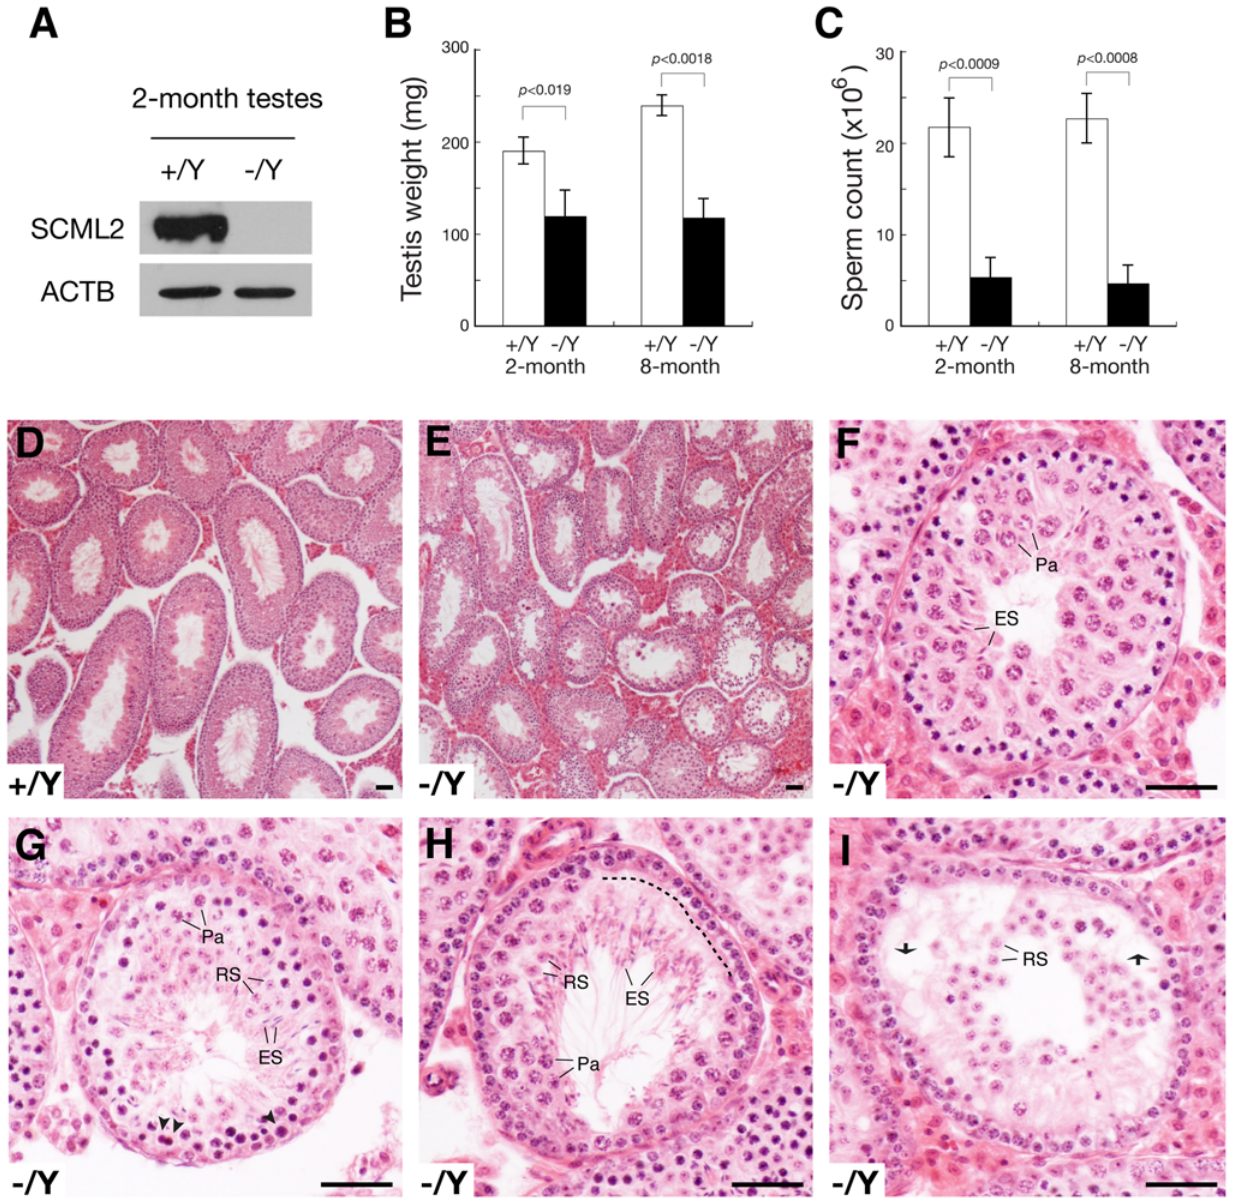
Figure 2. Defective spermatogenesis in Scml2 -/Y mice. (A) Western blot analysis of wild type and Scml2 -/Y testes. (B) Dramatic testis weight reduction (per pair of testes) in Scml2 -/Y mice. (C) Sharp reduction in sperm count (per pair of cauda epididymides) in Scml2 -/Y mice. The body weight of age-matched male mice was similar. Body weight at the 2-month age: wild type, 28.0 ± 1.5 g and Scml2 -/Y , 28.6 ± 1.0 g (n = 3 per genotype). Body weight at the 8-month age: wild type, 39.4 ± 4.7 g and Scml2 -/Y , 39.3 ± 5.5 g (n = 3 per genotype). (D) Histology of a 4-month-old wild-type testis at low magnification. (E-I) Variable spermatogenic defects in tubules from 4-month-old Scml2 -/Y testes. Testis section is shown in low magnification (E). Spermatogenesis in some tubules (F) is relatively normal. Apparently apoptotic spermatocytes are indicated by arrowheads (G). A layer of lost spermatocytes is marked by a dashed line (H). Some tubules (I) exhibit nearly complete depletion of pachytene spermatocytes. Vacuoles are indicated by arrows (I). Abbreviations (F-I): Pa, pachytene spermatocytes; RS, round spermatids; ES, elongated spermatids. Scale bars, 50 μ m.